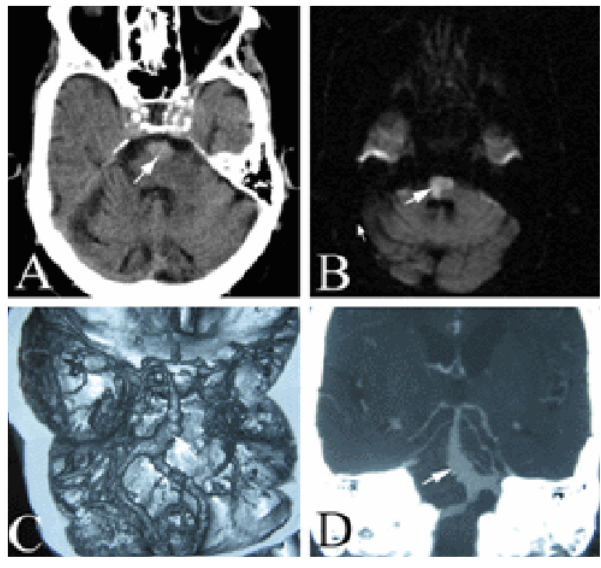
Figure 1. ( A ) CT scan of the brain showing an area of high density in the front of the pons (arrow) similar to a pontine hemorrhage. ( B ) Brain MRI revealed acute brainstem infarction (arrow). ( C , D ) CT angiography of the head showed a giant aneurysm of the basilar artery (27 mm by 10 mm)